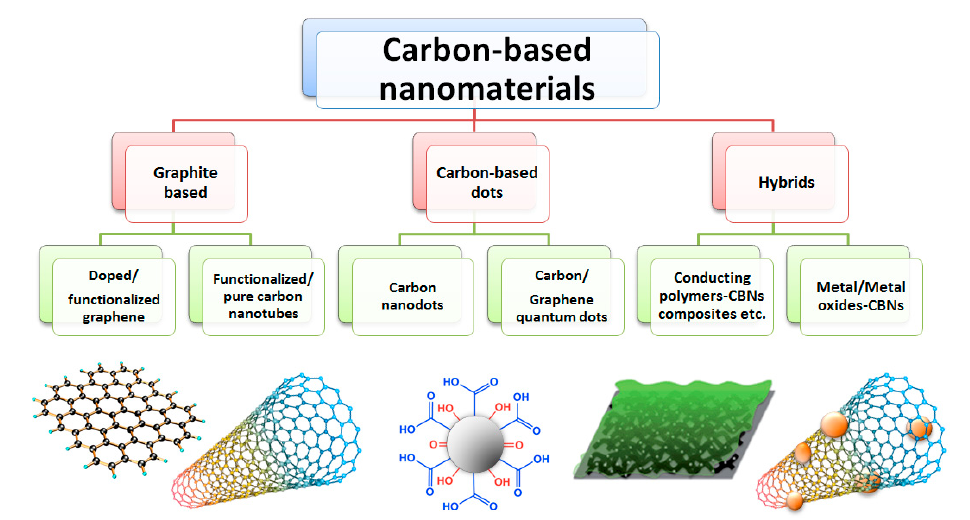
Figure 3. Carbon-based nanomaterials that have been and have potential to be used for biofuel-fed fuel cells.